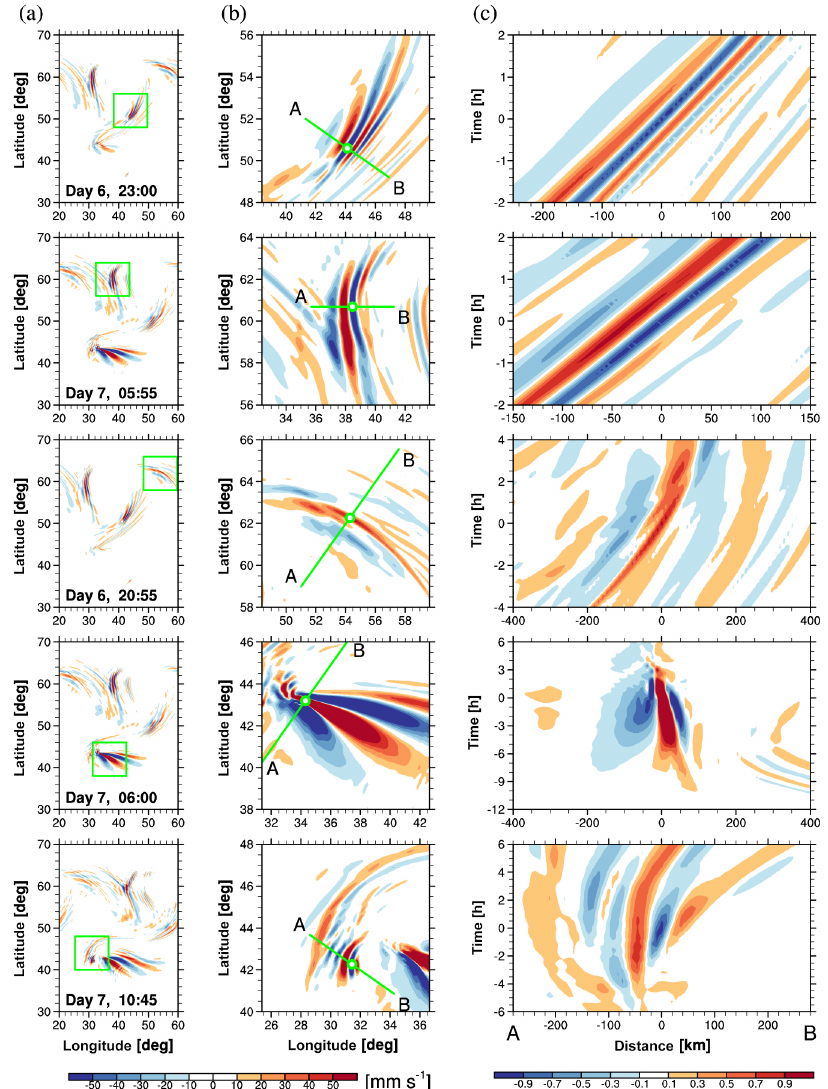
Figure 3. (a) w (cid:48) at z = 8km when the magnitude of w (cid:48) is largest for each of the five wave groups (W1–W5, see the text) (from top to bottom) and (b) enlargements of the green boxes in (a) . (c) Cross sections of w (cid:48) along the green lines in (b) with respect to the time relative to the instants in (a) and (b) . w (cid:48) in (c) is normalized by its maximum, and the normalized w (cid:48) for W4 is further divided by 5 for display purposes.